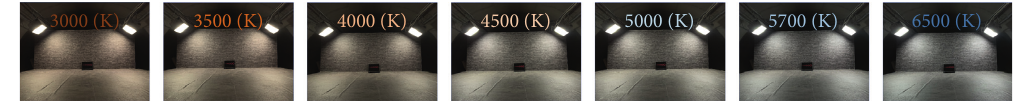
Figure 10: Experimental scene’s layout.